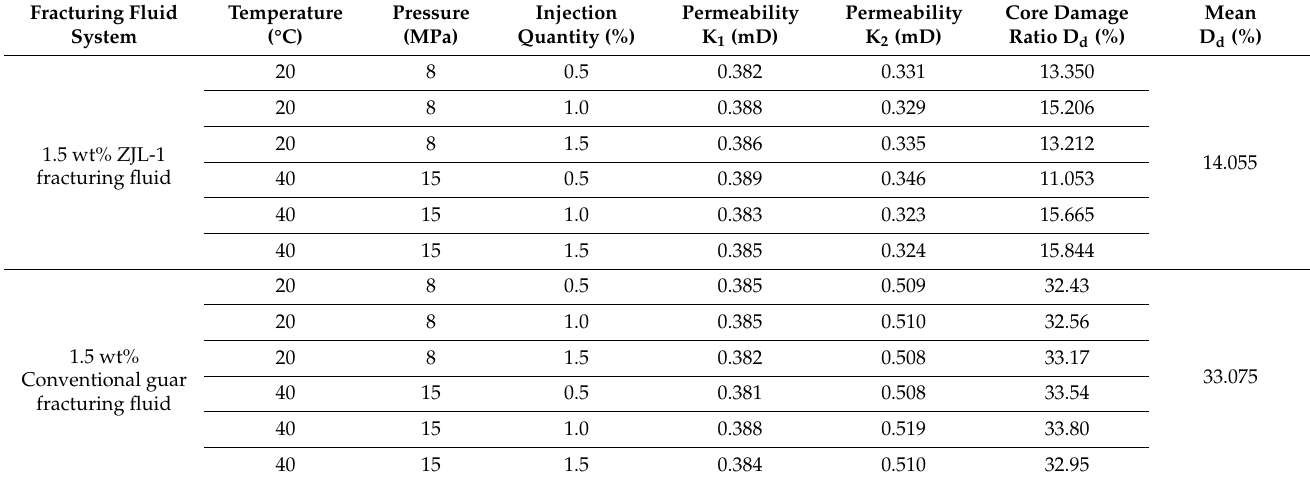
Table 3. Core damage properties of the ZJL-1 fracturing